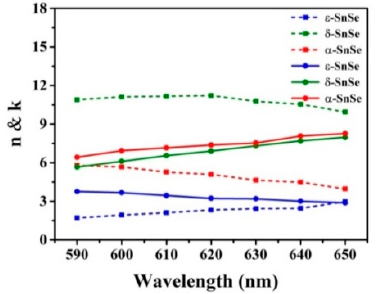
Figure 2. Measured refractive indices for the three SnSe allotropes [22].